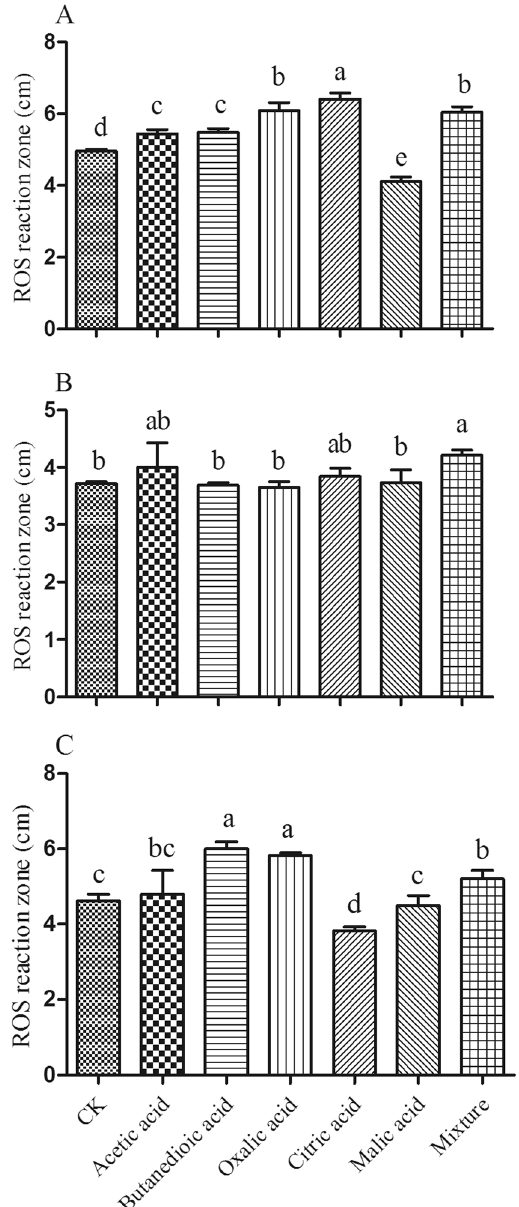
Figure 5. The effects of different organic acids at 120 μ mol/L on hydrogen peroxide production by the fungi. ( A ) represents F. oxysporum ; ( B ) represents T. helicus ; ( C ) represents F. moniliforme . Columns with different letters are statistically different (LSD test, p <